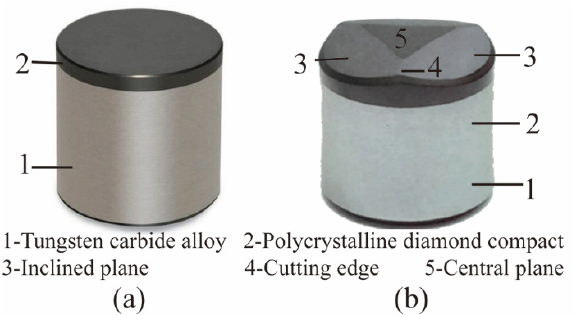
Figure 2. Illustration of ( a ) Conventional planar-cutter and ( b ) Three-ridged diamond element (3-RDE) non-planar cutter.